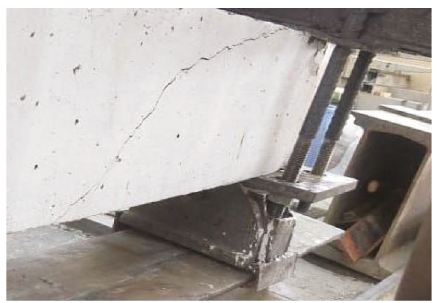
Figure 4: The support of the tested beam.